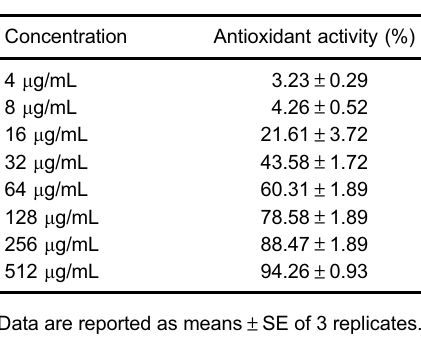
Table 3. In vitro antioxidant activity (% of 2 mM ascorbate as a standard) of Beta vulgaris leaf and stalk extract (4 B 512 m g/mL) indicated by DPPH assay.